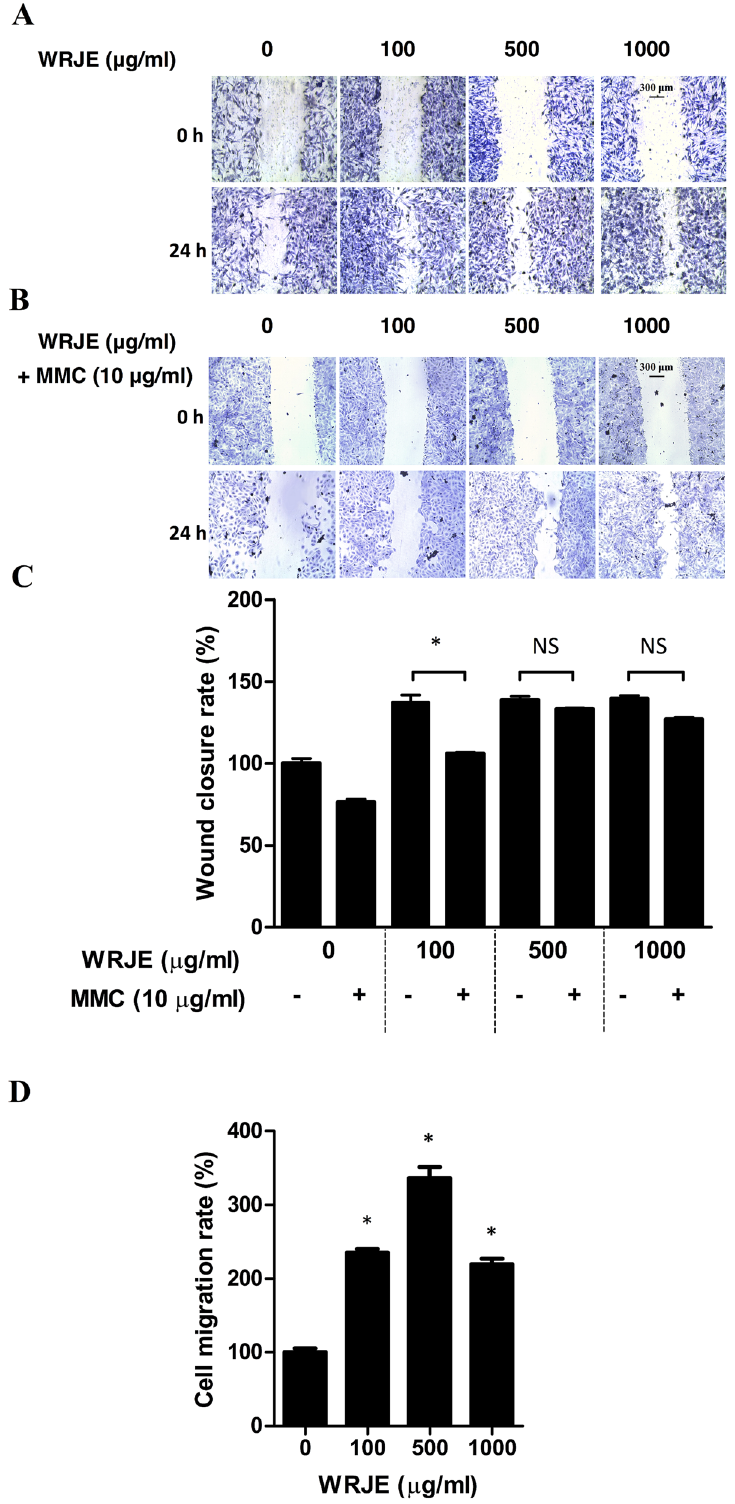
Figure 2. In vitro wound healing properties of a water royal jelly extract (WRJE) in HaCaT cells. Scratch wound analyses were performed in confluent monolayers of HaCaT cells. ( A ) Wounded cells were treated with different doses of WRJE for 24 h. ( B ) Scratch wounding with HaCaT cells was also conducted by pre-treating HaCaTcells with 10 μ g/ml mitomycin C for 2 h and subsequent treatment with WRJE for 24 h. ( C ) Wound closure rates were determined as the difference between wound width at 0 and 24 h. ( D ) HaCaT cell migration was evaluated by the transwell assay plate (8 μ m pore size, ThinCert ™ 24 Well Cell Culture Inserts), where the cells were treated with different doses of WRJE for 24 h. Asterisks indicate a significant difference from the untreated group, * P < 0.001. Scale bar = 300 μ m. NS: